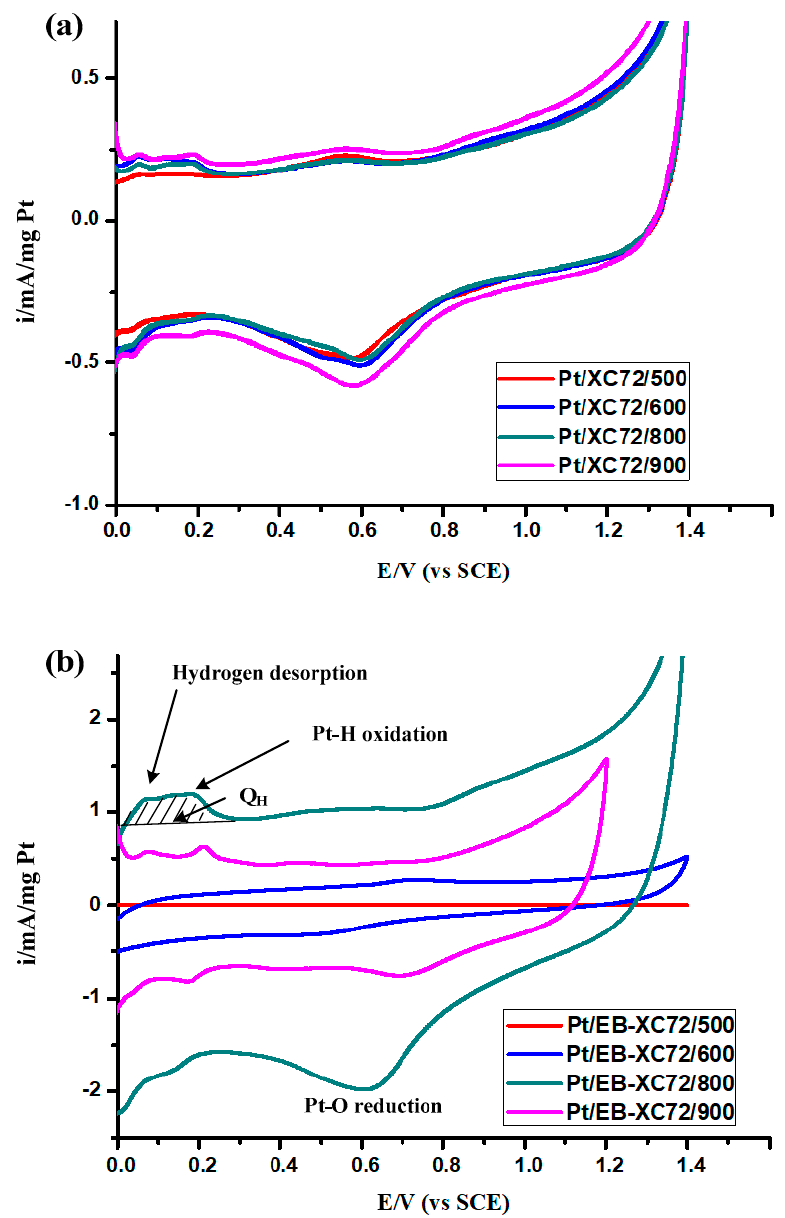
Figure 7. The cyclic voltammetry (C-V) curves of Pt-catalysts treated at different temperatures: ( a ) ( a ) without EB and ( b ) with without EB and ( b ) with EB. Table 4. Particle size and electrochemical properties of Pt-catalysts.